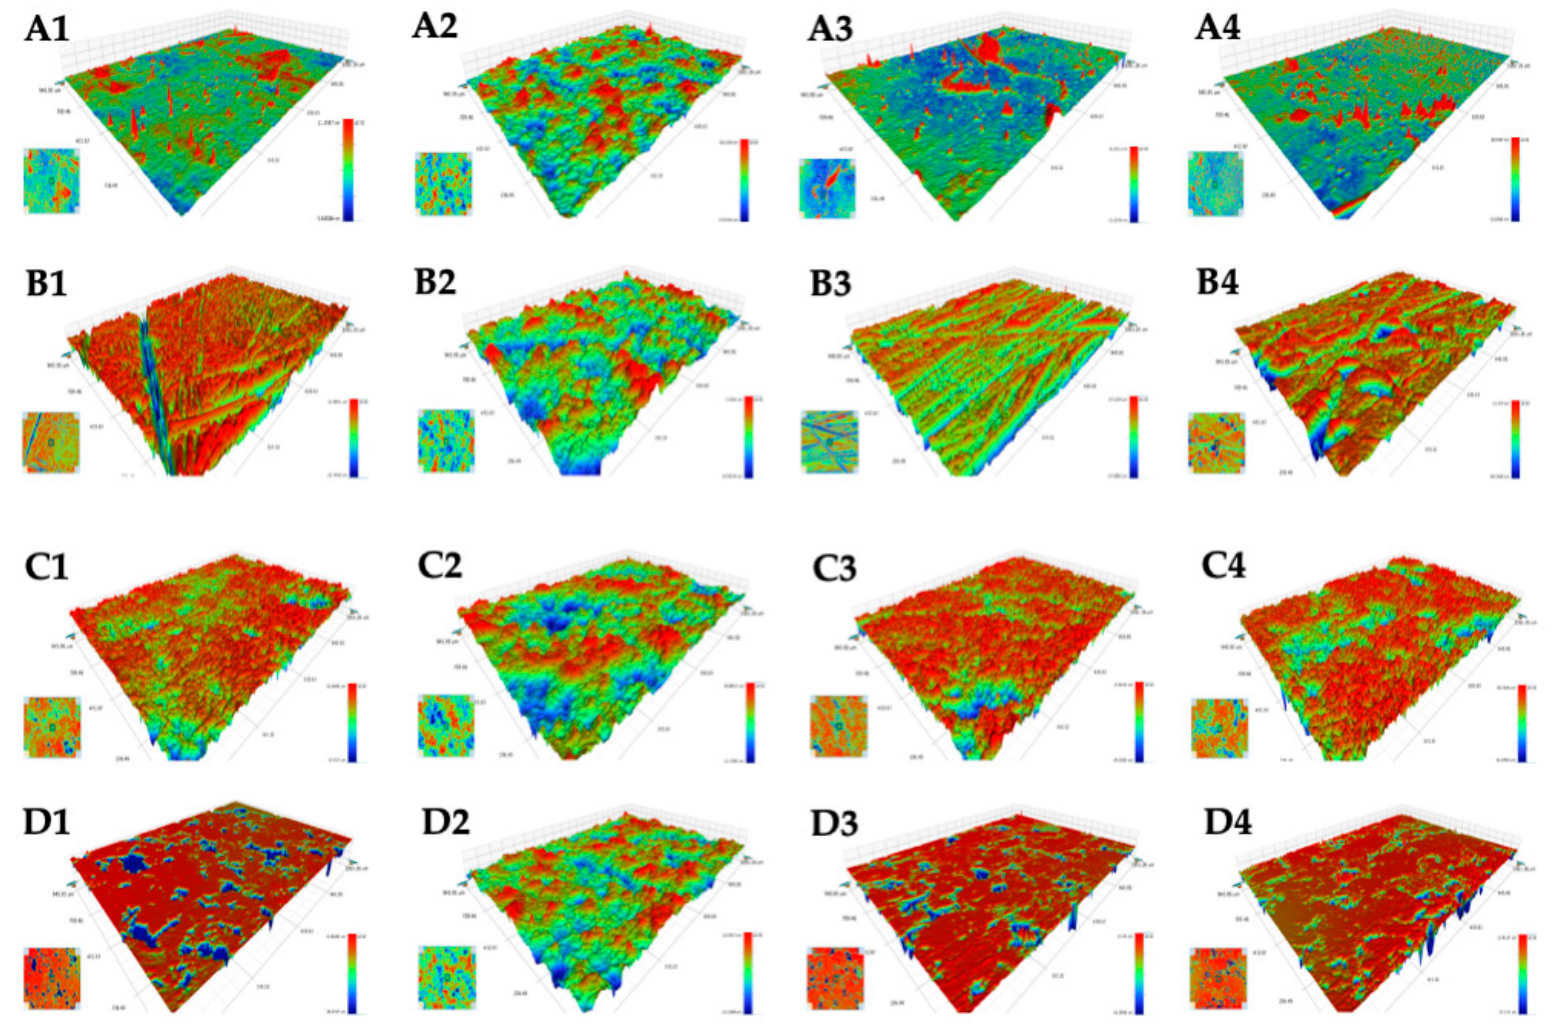
Figure 3. Optical profilometer images of 0.94 × 1.3 mm 2 surface areas of A —glass (G), B —aluminum (Al), C —stone (S), D —marble (M), 1—bare surface sample, 2—surface covered with paint, 3—surface after removal paint coating with NE No. 10 removal, and 4—bare surface after cleaning with NE No. 10.